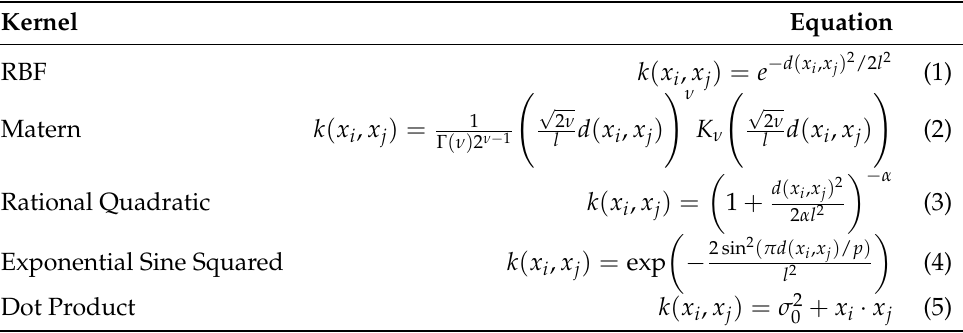
Table 1. Common Kernels used for